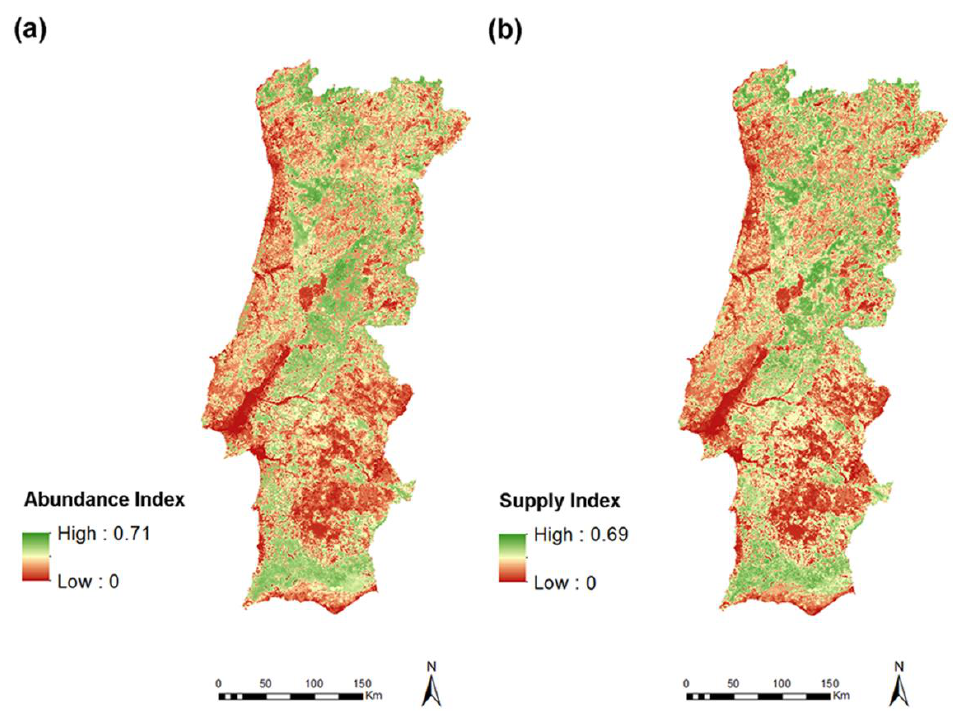
Figure 4. Spatial distribution of InVEST crop pollination model outputs ( a ) abundance index and ( b ) supply index in 2018.